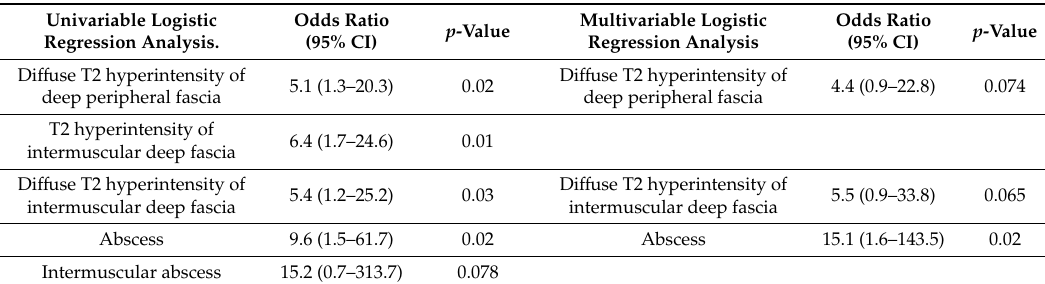
Table 3. Multivariable logistic regression analysis of predictive magnetic resonance findings for necrotizing